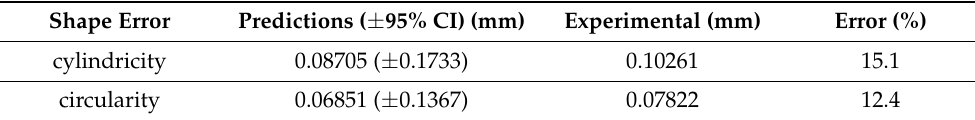
Table 8. Comparison of cylindricity and circularity predicted by ANOVA and confirmation experiment. Shape